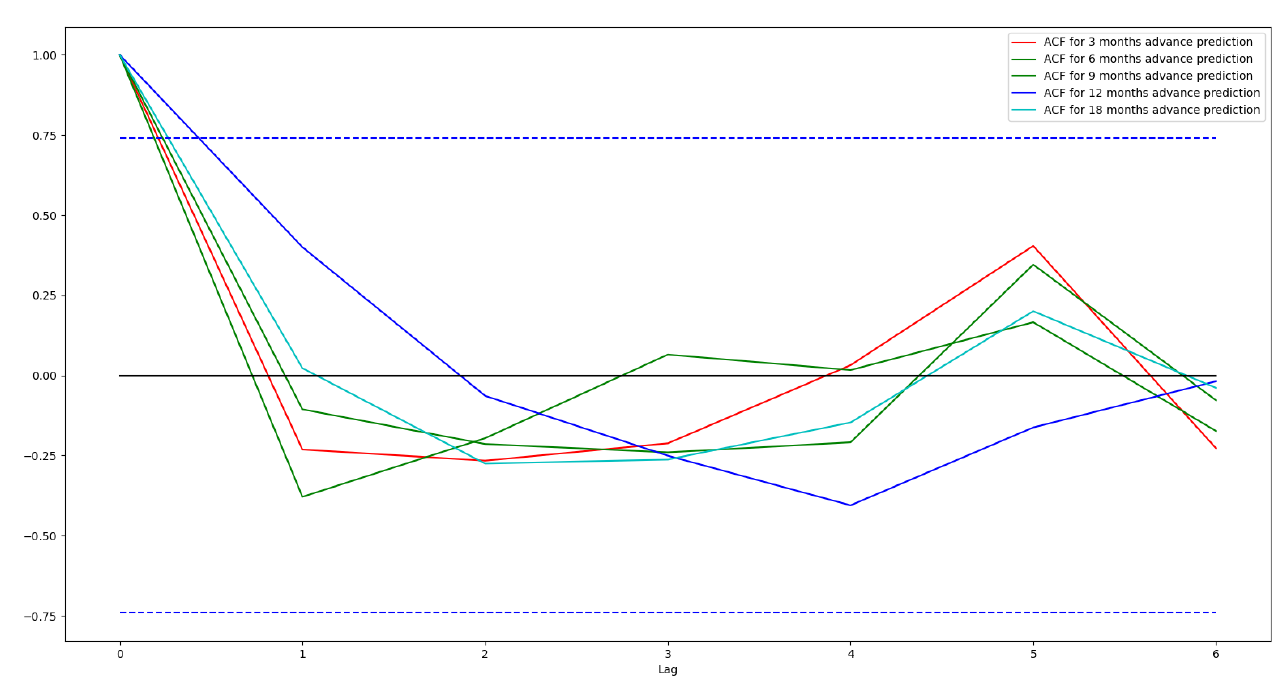
Figure 7. Autocorrelation function plots for residuals from ACE prediction models. Dashed blue lines show intervals for 95%